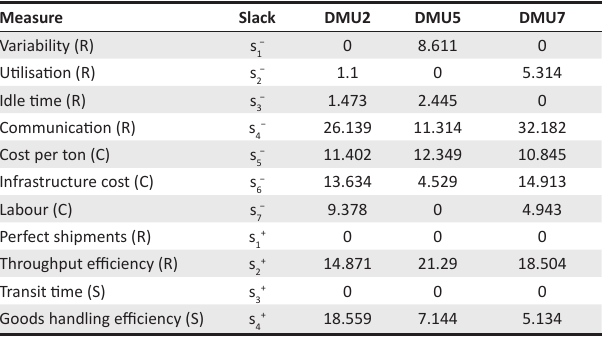
TABLE 3: Rail node slacks analysis results.